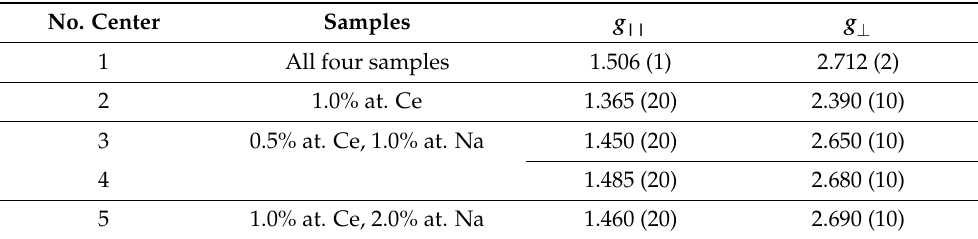
Table 3. The values of g-parameters of Ce 3+ centers with axial symmetry in the BaWO 4 : Ce and BaWO 4 : Ce, Na single crystals